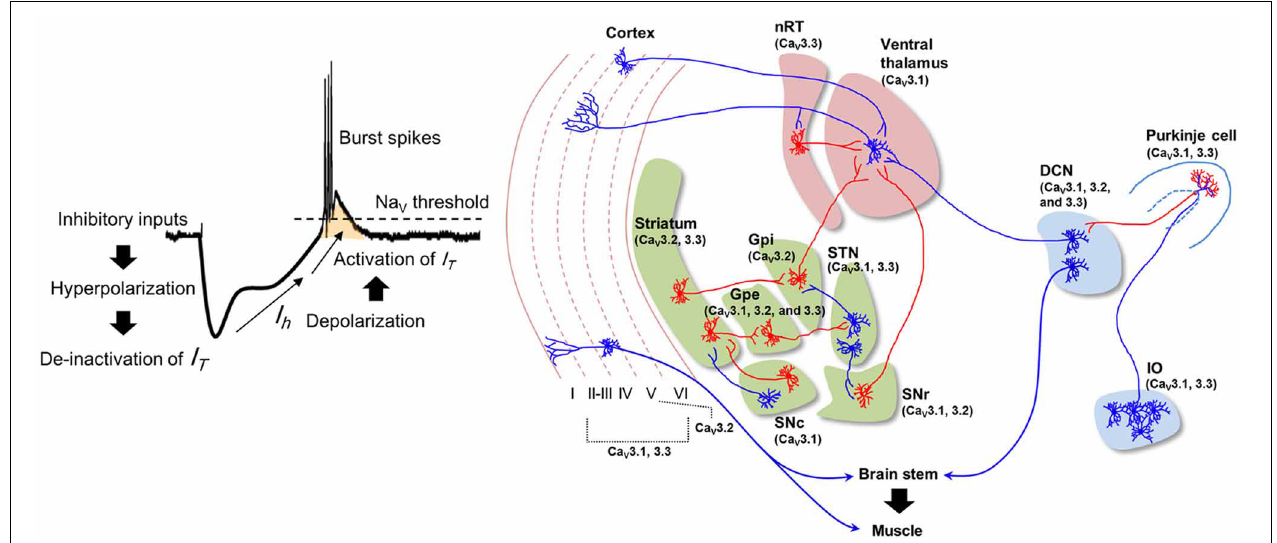
FIGURE 1 | T-type Ca 2 + channels and pathological tremor pathways. Potentiation of T-type Ca 2 + conductance and the generation of low-threshold spikes (LTS) ( left ). Hyperpolarization and subsequent depolarization by HCN channel-mediated currents ( I h ) open T-type Ca 2 + channels. I T : T-type calcium current; Na V : voltage-gated sodium channel. Neural pathways involved in pathological tremors ( right ). Blue indicates excitatory neurons, and red indicates inhibitory neurons. The blue regions represent the olivocerebellar